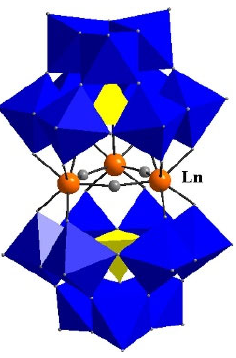
Figure 10. Structure of a Ln 3 O 3 (SiW 9 O 34 ) 217 − /15 − POM with the WO 6 octahedra shown in blue and the SiO 4 tetrahedra shown in yellow [58]. Reproduced with permission from ref. [58]. Copyright 2020 Elsevier.